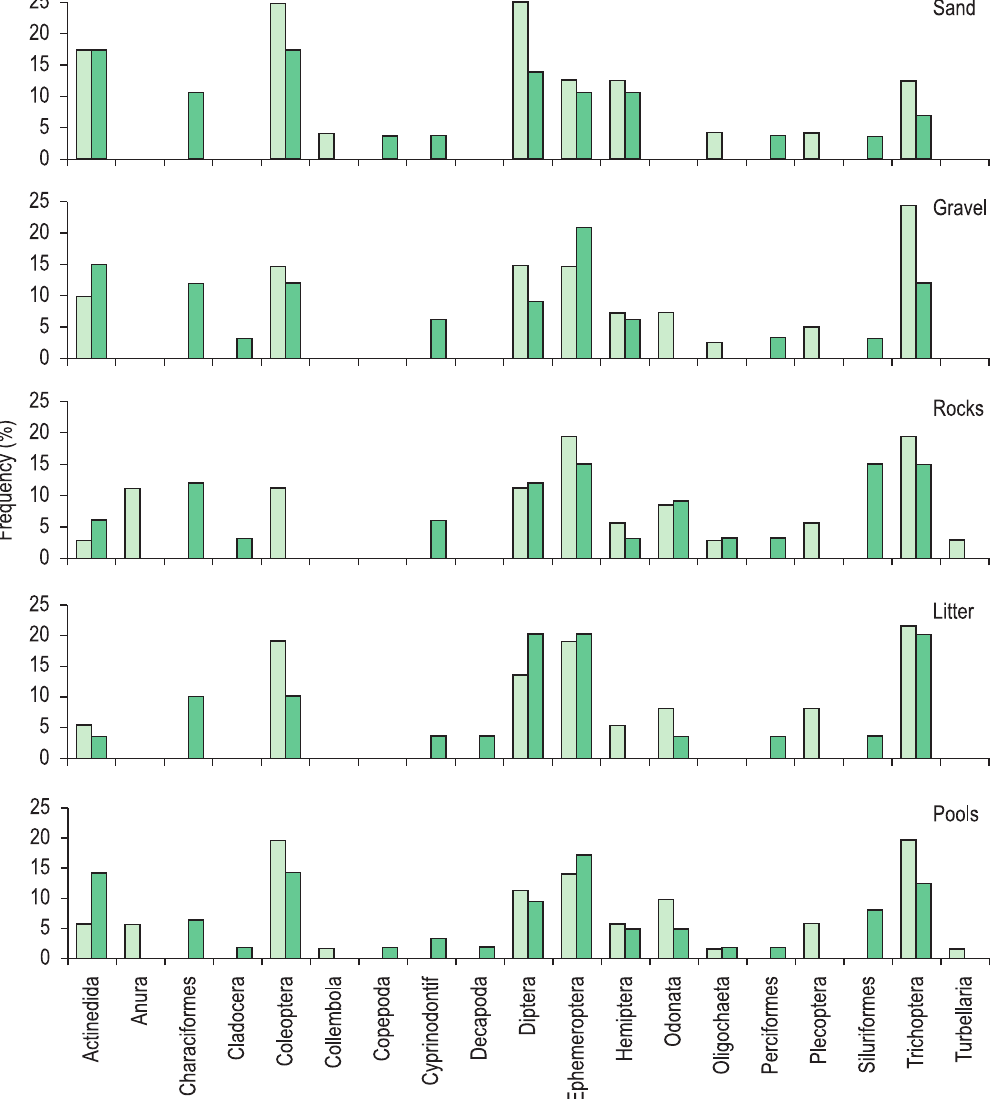
Figure 2. Taxa frequency that show composition dominance on each substrate for upstream pool (white bars) and downstream pool (black